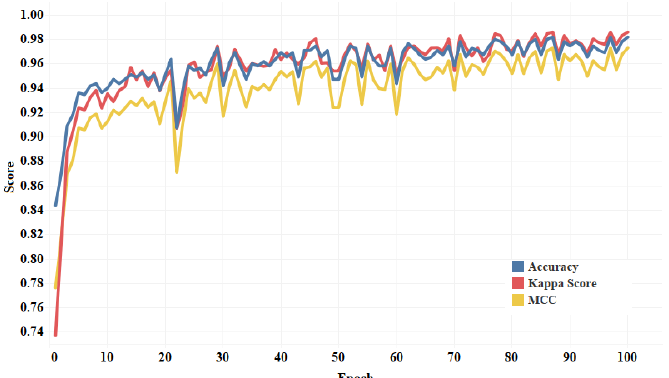
Figure 8. Graphical plot of Mathews correlation, kappa score, and accuracy for LW-CORONet model.